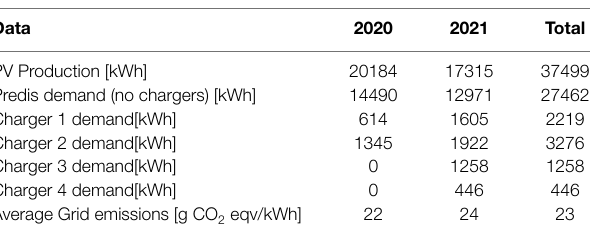
TABLE 2 | Summary of the Predis-MHI data.